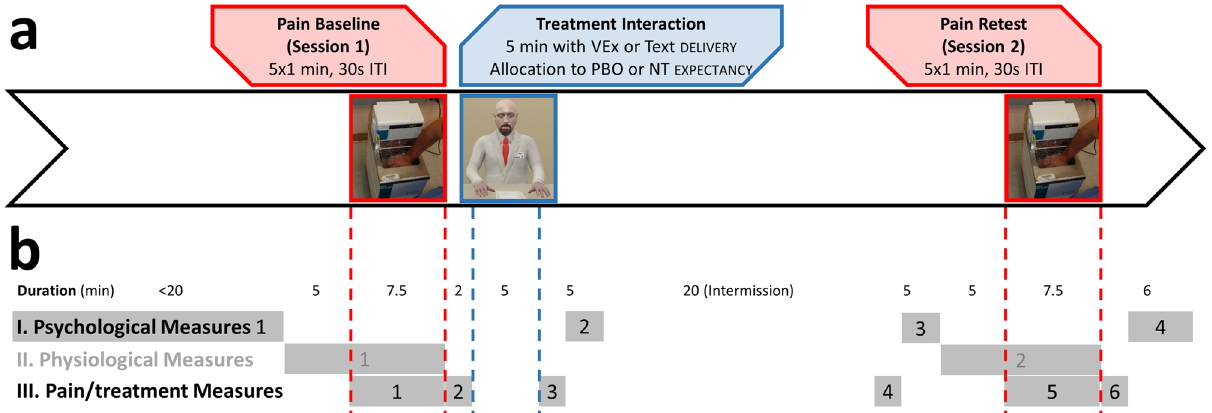
Figure 1. Experimental design and protocol. ( a ) Between pain baseline and retest including 5 hot water immersions, subjects were randomly assigned to Delivery and Expectancy conditions. Virtual experimenter screen captured in Unity. ( b ) Timing of measurements. Approximate durations are displayed in the upper row, grey areas indicate the duration of individual measurements, as described below. I. Four psychological measurements, 1 (General Information, IPC, LOT-R, PVAQ, FPQ-III, BFI-44, STAI-Trait, PHQ9, PHQ15, STAI-State 1, MDMQ-SF1), 2 (SPS, NMQ, EIC), 3 (STAI-State 2, MDMQ-SF2), 4 (Manipulation check, exploratory items). II. Physiological measures (data not shown). III. Pain/treatment measures, 1 (continuous ratings), 2 (retrospective ratings), 3 (side effects questionnaire, expectation of pain relief), 4 (side effects questionnaire), 5 (continuous ratings), 6 (retrospective